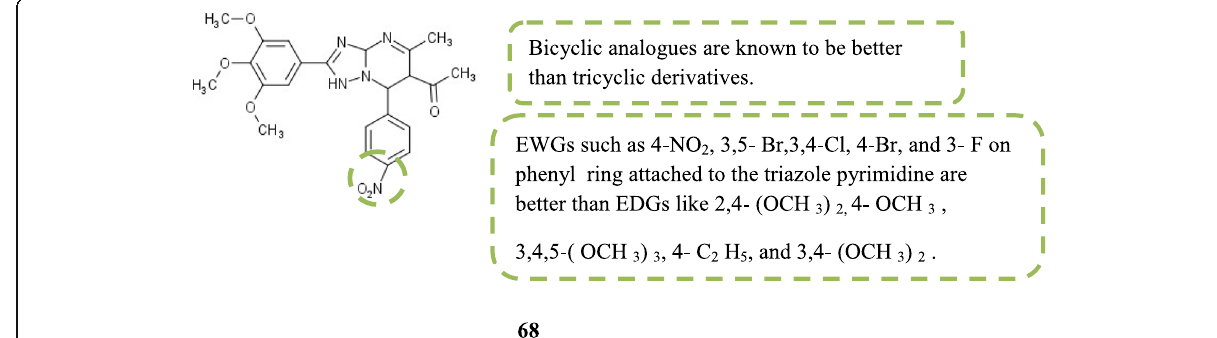
Fig. 22 SAR studies and chemical structures of [1, 2, 4] triazolo [1, 5-a] pyrimidine